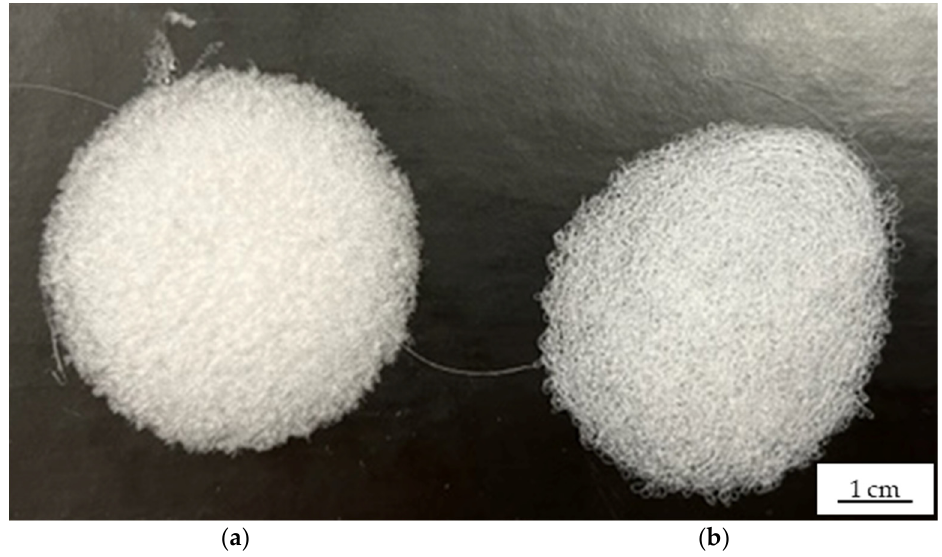
Figure 6. Fiber web samples produced using single-nozzle laboratory-scale melt-electrospinning equipment. ( a ) Negatively charged ( − 30 kV) collector. ( b ) Positively charged (+30 kV) collector.